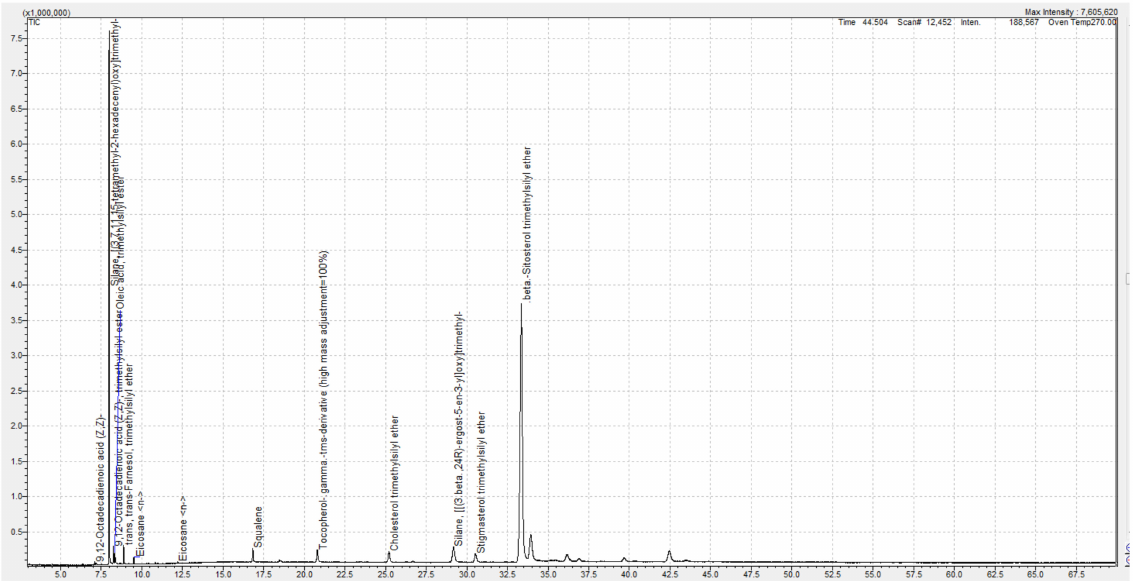
Figure 4. GC-MS chromatogram of unsaponifiable matter from Tilia seed oil after the